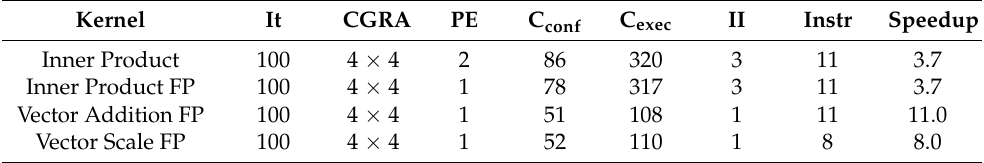
Table 1. Streaming kernel results.